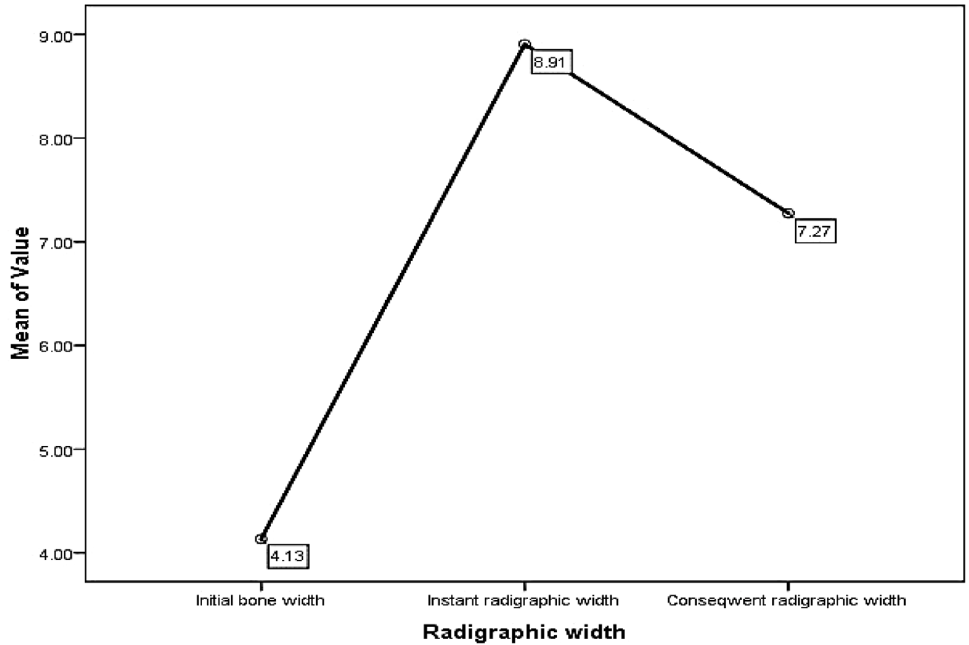
Fig. 3. Mean radiographic overall width measurement changes of the alveolar crest at T0, T1 and